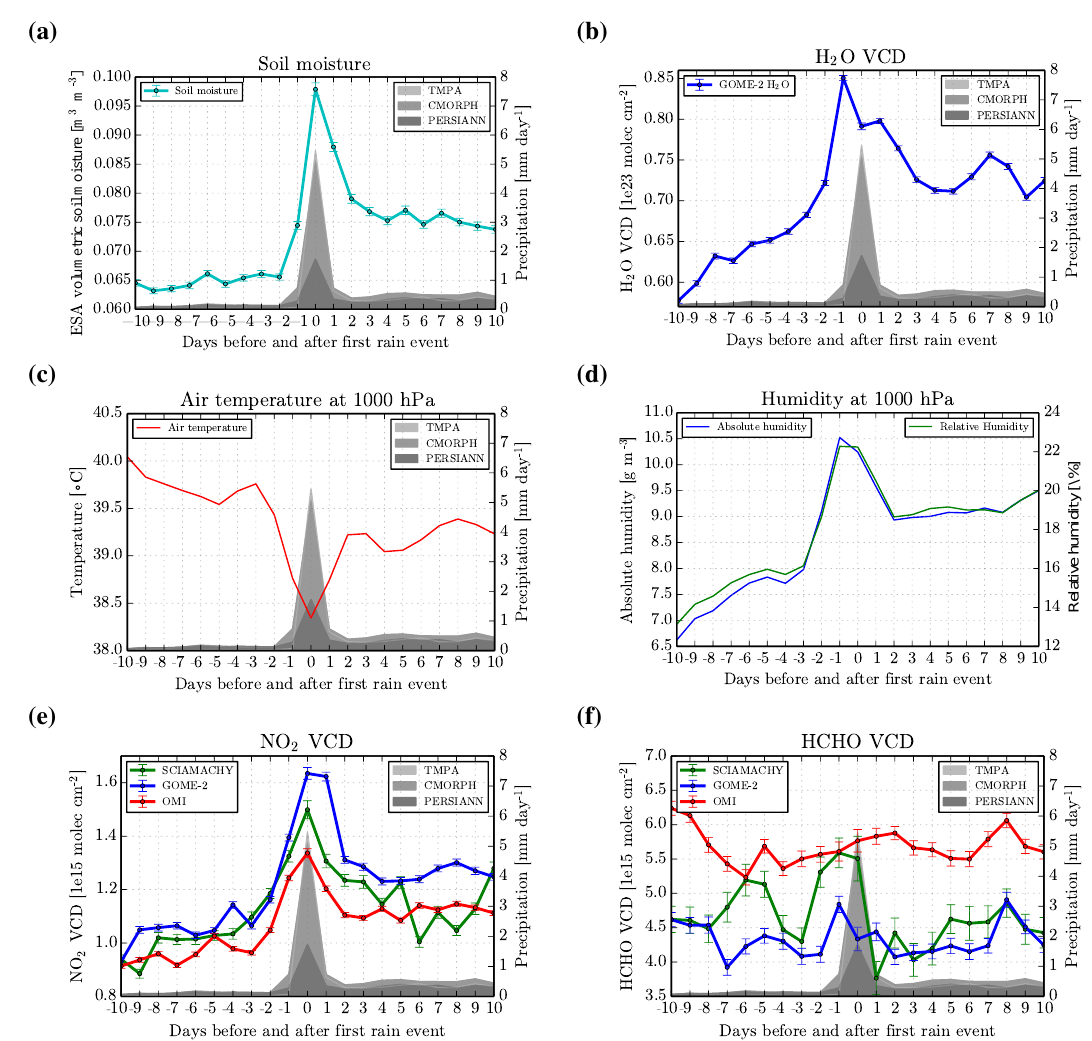
Figure 5. Temporal evolution of several quantities around the day with the first rain event for the Sahel region after at least 60 days of drought for April/May/June (2007–2010). Grey shaded areas represent precipitation estimates from TMPA, CMORPH and PERSIANN. (a) Blended ESA CCI soil moisture. (b) Water vapour total column densities from GOME-2. (c) Temperature at 1000hPa from ECMWF Interim Analysis. (d) Relative and absolute humidity at 1000hPa from ECMWF Interim Analysis. (e) NO 2 VCDs from SCIAMACHY, GOME-2 and OMI with standard mean error (SME). (f) HCHO VCDs from SCIAMACHY, GOME-2 and OMI with SME.